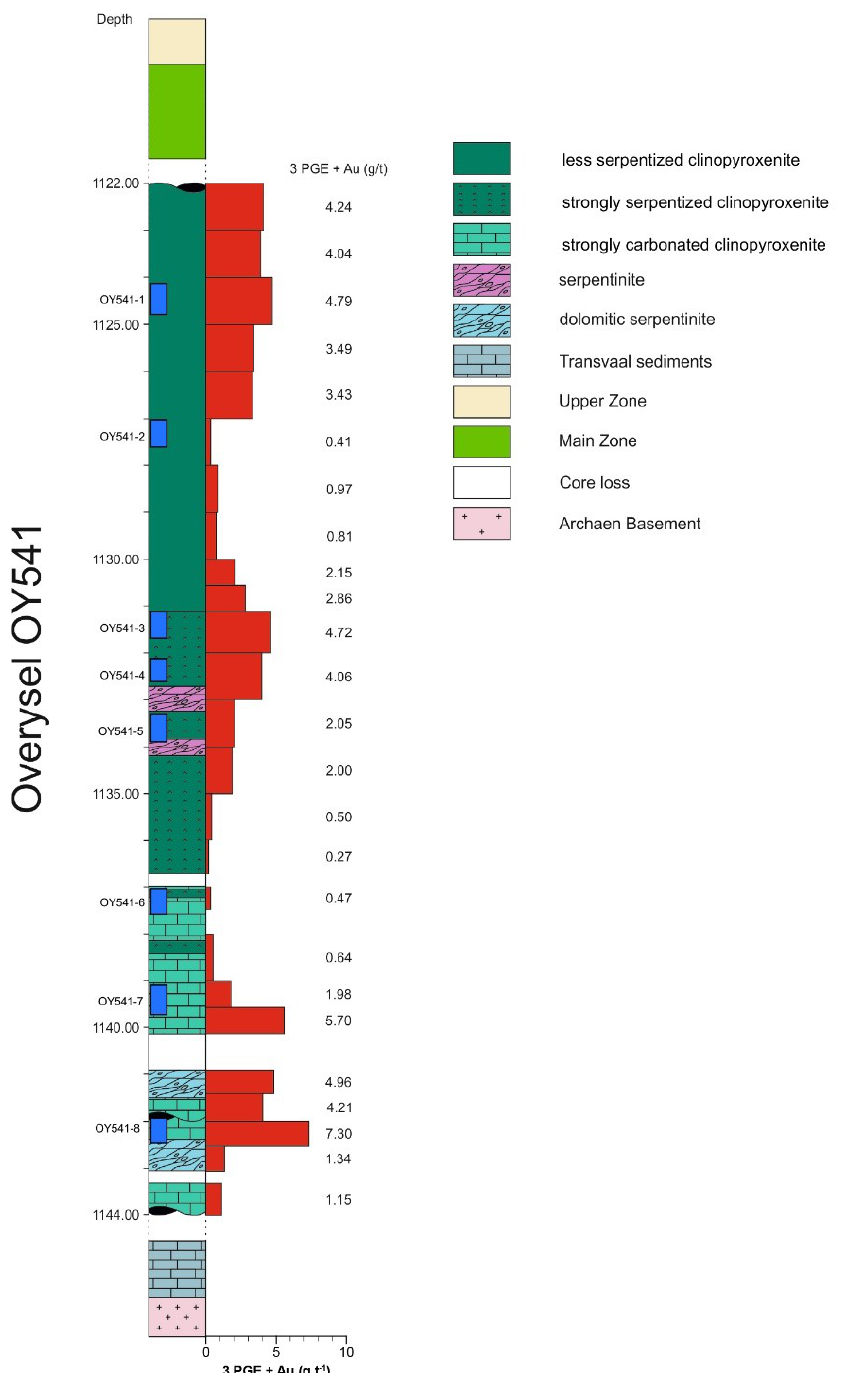
Figure 2. Simplified stratigraphy of the borehole (OY541) showing the clinopyroxenite package, which forms the footwall to the Platreef at Overysel based on the present study and core log information provided by Anglo Platinum. Grade and distribution of mineralization is indicated by red boxes (3PGE + Au). The numbers attached on the left give the sample depth in meters. The blue rectangles mark the sections studied here.